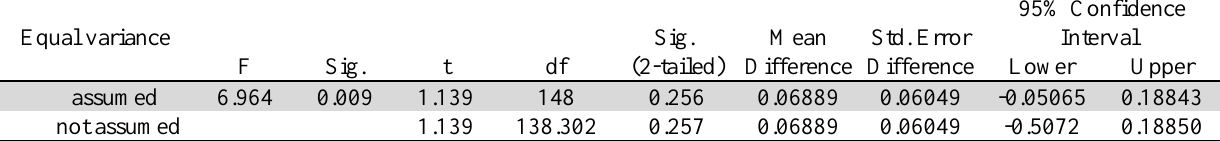
t-test in order to compare the means Equal variance F Sig. df assumed not assumed